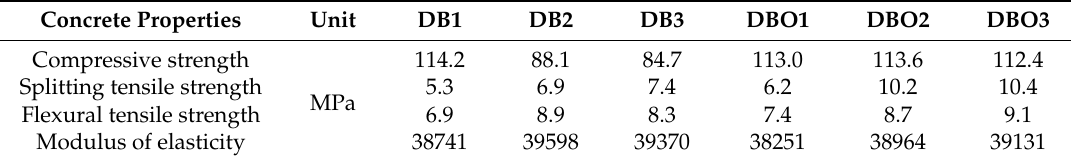
Table 2. Mechanical properties of concrete and fibre reinforced concrete.